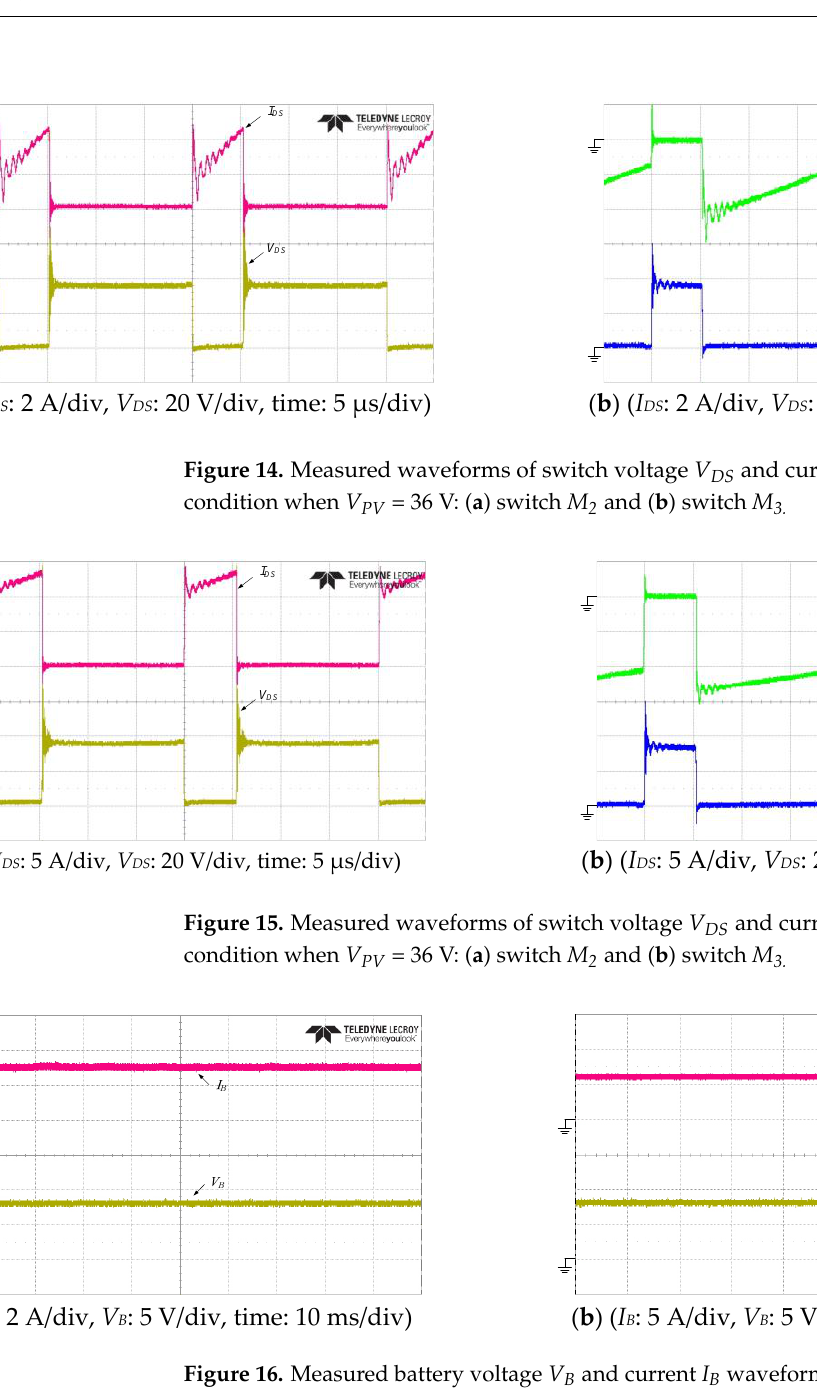
shows measured solar power voltage V PV , current I PV and power P PV waveforms under the maximum solar power P PV(max) = 50 W. In Figure 18, when solar power P PV varies from 0 W to 50 W, the MPPT time interval is about 330 ms. That is, the proposed hybrid converter can achieve MPPT features. Figure 19 expresses the conversion efficiency curve of the pro- posed hybrid converter operated in the solar power condition from light load to heavy load. In Figure 19, the maximum conversion efficiency is 95% under 80% of the full-load condition. When the proposed hybrid converter is operated under 100% of full-load con- dition, its conversion efficiency is about 91%. According to power loss analysis, driving circuit and stray losses are about 21.7% of total power loss. Losses of switches are approx- imated to 42.7%, while losses of transformer T r are approximately 35.6%. As mentioned